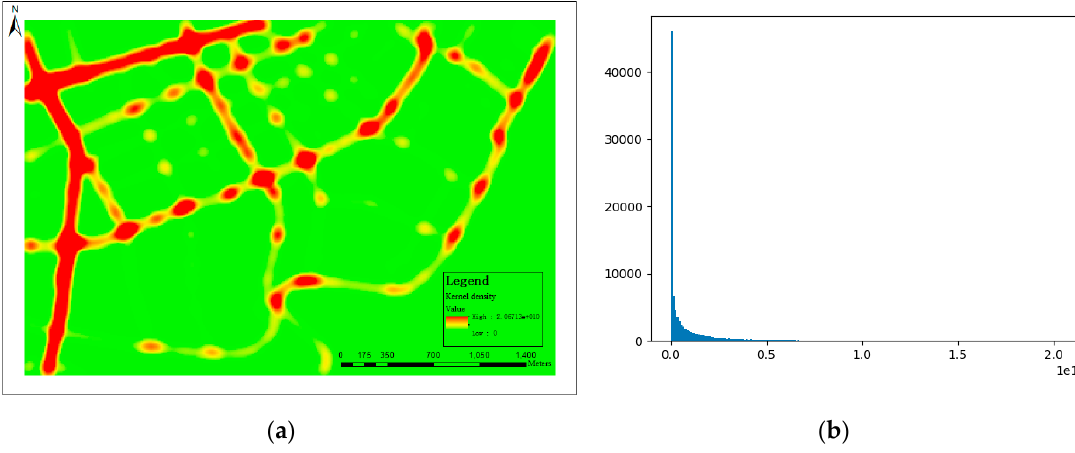
Figure 7. Estimating density: ( a ) Kernel density; ( b ) statistical distribution.